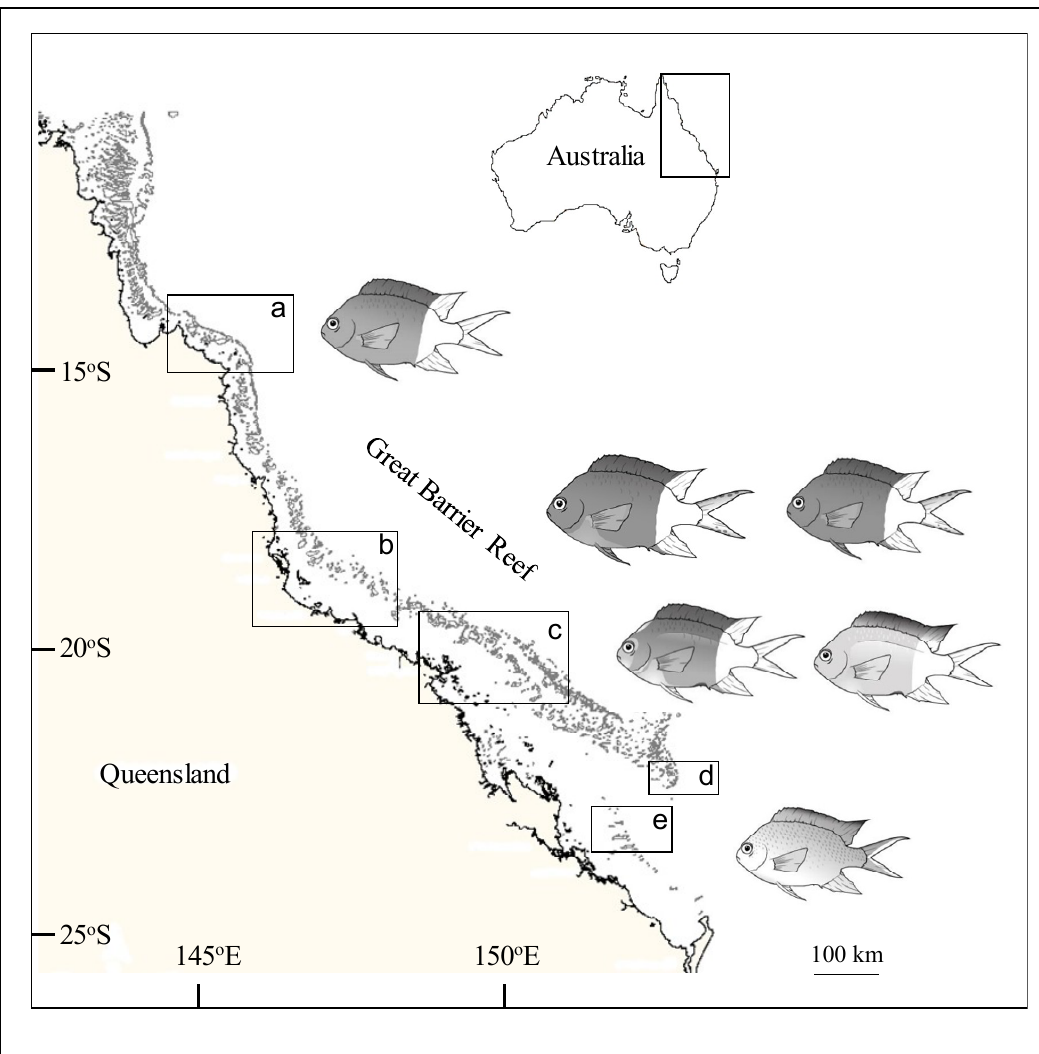
Figure 1. Location of latitudes sampled for Acanthochromis polyacanthus on the Great Barrier Reef (GBR) with inserts indicating latitudinal positions as follows: Lizard ( a ), Townsville ( b ), Whitsunday ( c ), Swains ( d ), and Capricorn/Bunker ( e ). Outlines of the color morphs of Acanthochromis polyacanthus by latitude are provided; larger images in color are provided in Figure S1 (Supplementary Materials).